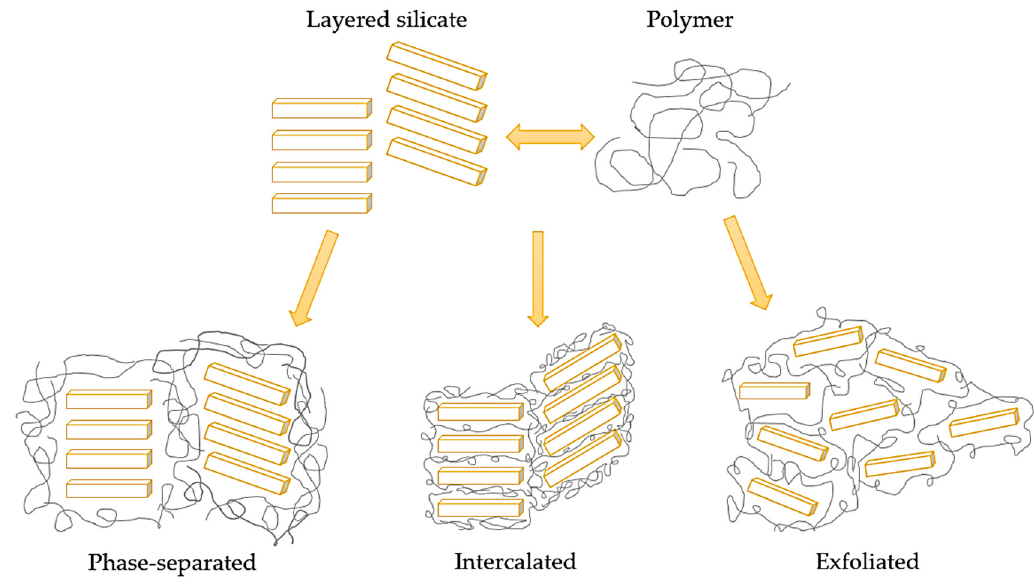
Figure 6. A scheme of dispersion states of the clay in the polymer matrix [106].